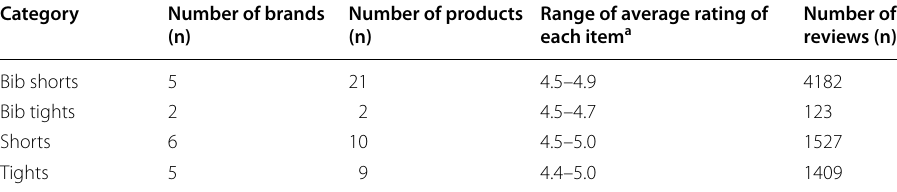
a It was converted from one to five according to a star rating of the